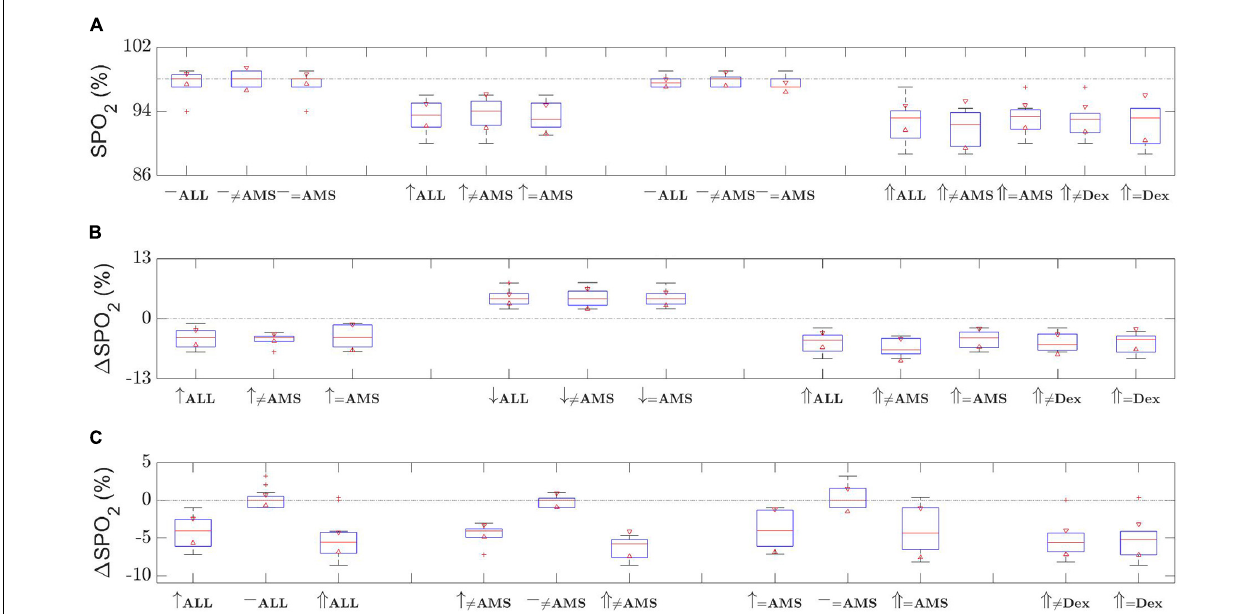
FIGURE 2 | Oxygen saturation (SPO2) changes over the time of the two ascents. Shown are (A) distribution of SPO2 level measurements, (B) relative change in SPO2 level with respect to last measurement, and (c) relative change in SPO2 level with respect to first baseline measurements. Time evolves left to right in (A,B) , and in (C) dotted line depicts the 0% change level. [Red triangles represent boxplot notches at the 95% confidence level; whiskers correspond with one standard deviation from the mean; red plusses are outliers; (cid:54)= non-AMS or non-dexamethasone (Dex); ↑ first ascent; ↓ descent; ⇑ second ascent; – either first or second baseline; the dash-dot line in (A) depicts the first baseline mean, in (B,C) they show the 0% change, provided as a guide in all